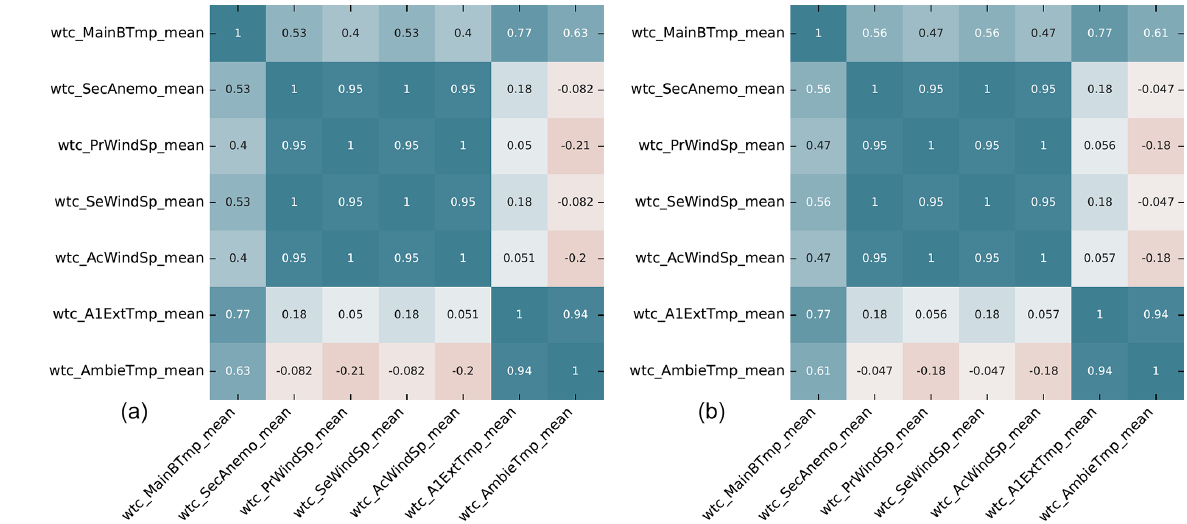
Figure 5. Pearson correlation heat map of preselected variables (a) and Spearman correlation heat map of preselected variables (b) .